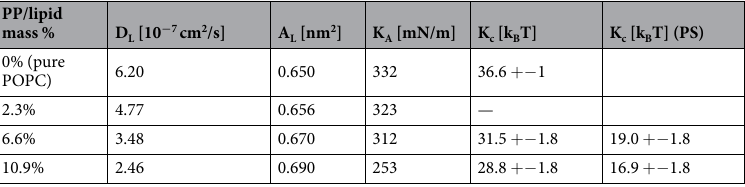
Table 2. POPC bilayer properties in the presence of different amounts of PP107. All metrics are averaged over the last 8 microseconds of simulation. Uncertainties are below 5% for D L , and below 1% for A L and K A . The last column contains the bending modulus data obtained in the presence of PS, for